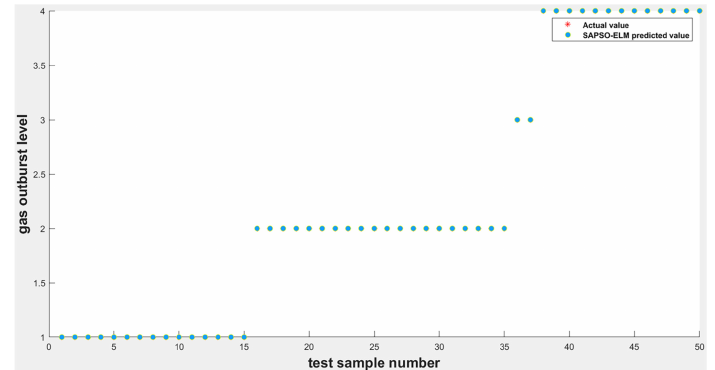
Figure 3. SAPSO-ELM model simulation output